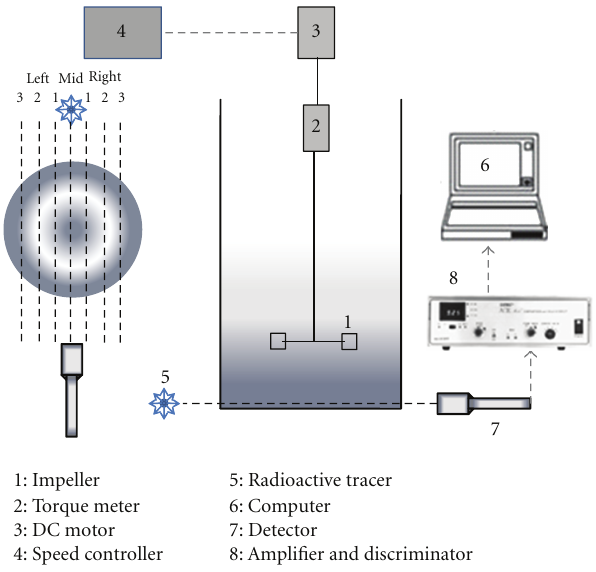
Figure 1: Experimental setup and gamma-ray densitometry data acquisition system.